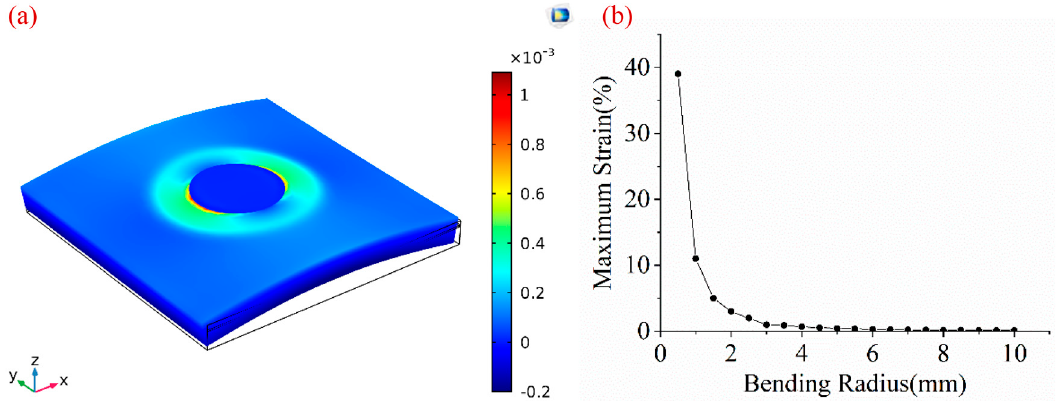
Figure 14. ( a ) The chart of maximum strain solved by FEA. ( b ) Correlation of the bending radius versus maximum strain in a device membrane.